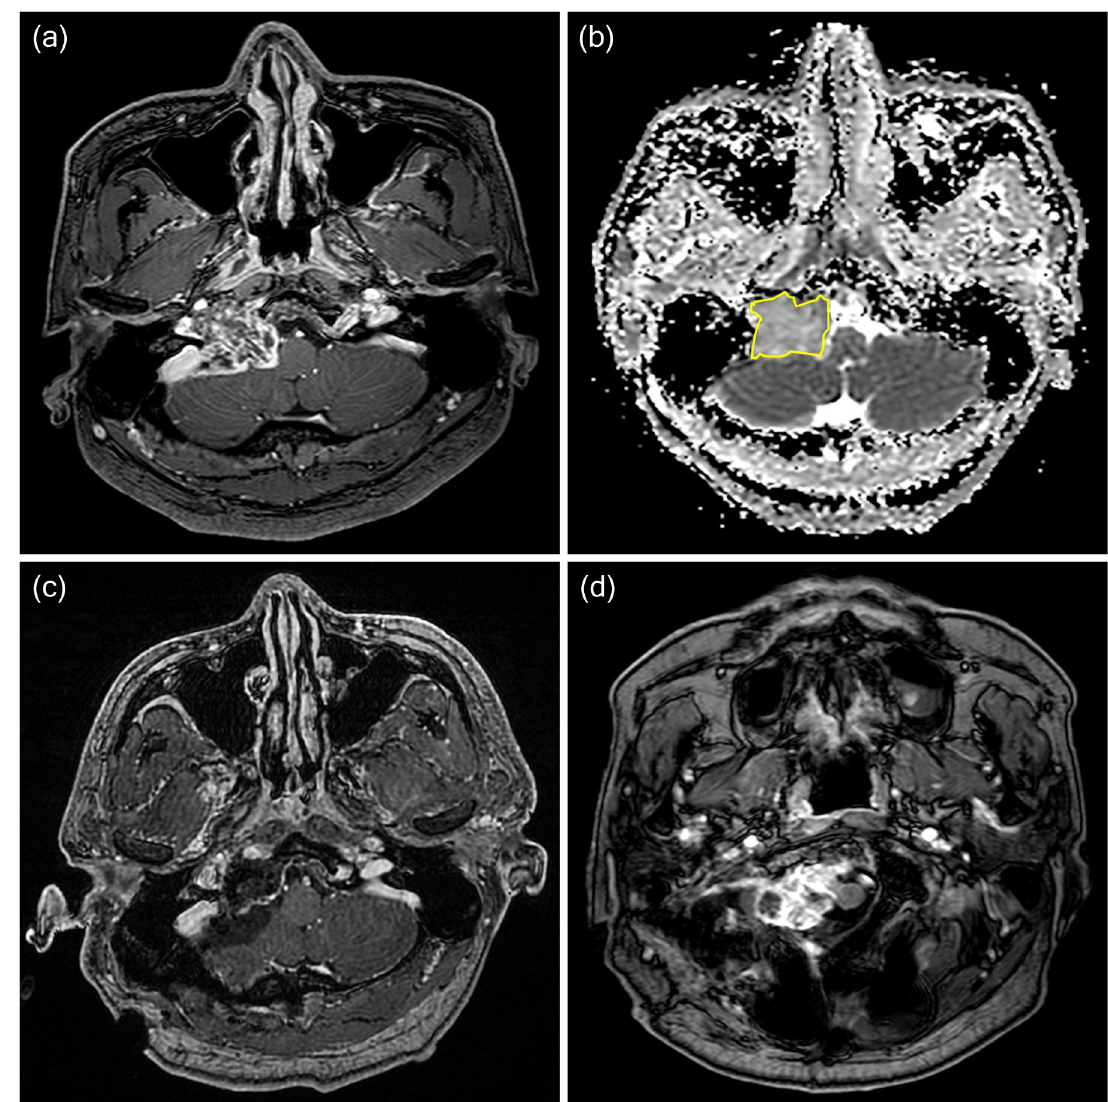
Figure 4. A 37-year-old man was diagnosed with classic chordoma and placed in the aggressive group. ( a ) Preoperative contrast enhanced T1-weighted imaging showed a tumor compressing the brainstem. ( b ) The ROI is outlined in yellow on the ADC map and represents decreased water diffusivity (mean ADC 1107 × 10 –6 mm 2 /s, minimum ADC 877 × 10 –6 mm 2 /s). ( c ) Immediate postoperative contrast enhanced T1-weighted imaging shows gross total removal. Surgery was performed via the far lateral transcondylar approach. The patient received proton-based radiotherapy 3 months after surgery. ( d ) Contrast-enhanced T1 weighted imaging obtained 2 years later showed an increase of the mass adjacent to the previous surgical site. The patient died of disease 7 months after the last MRI due to